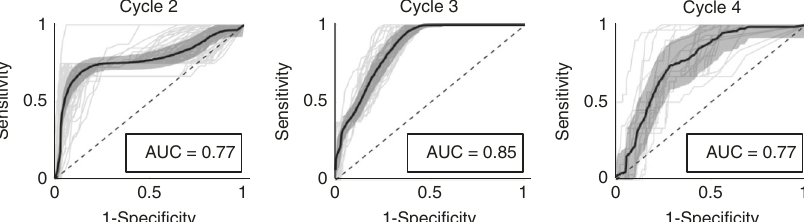
Fig. 4 Leave-one-out study ROC analysis. Individual ROC curves for each leave-one-out cohort (gray curves), with mean ROC curve and corresponding 95% con fi dence interval (black). AUC 95% con fi dence intervals are (0.76, 0.78), (0.85, 0.86), and (0.74, 0.80), for cycles 2, 3, and